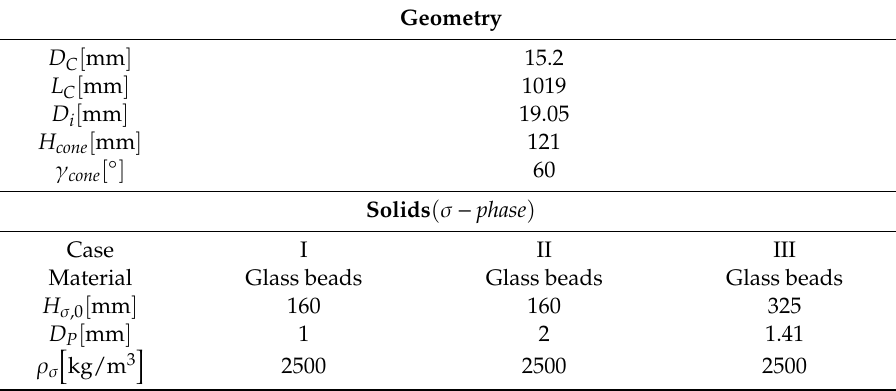
Table 2. Geometrical properties of the experimental setup and operation